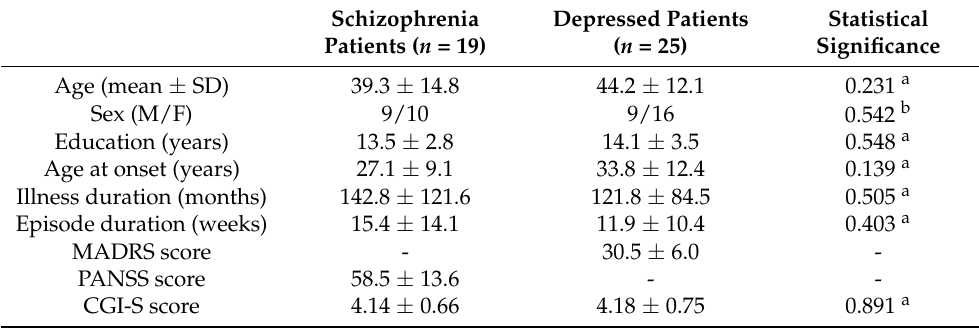
Table 1. Demographic and clinical characteristics of the